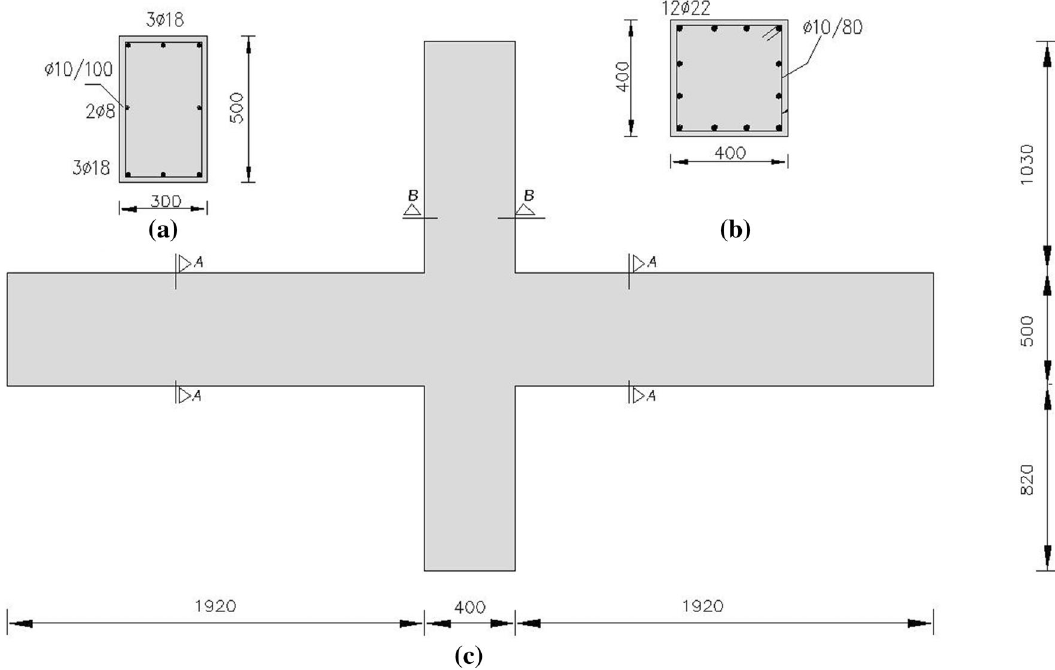
Fig. 4 Geometry and reinforcing details for monolithic specimen a beam section, b column section, and c interior connection.